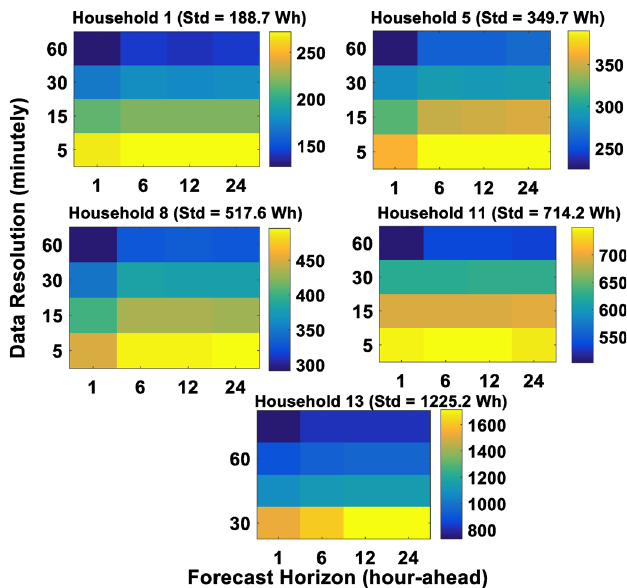
Fig. 4. RMSE results of resolution versus horizon analysis on chosen